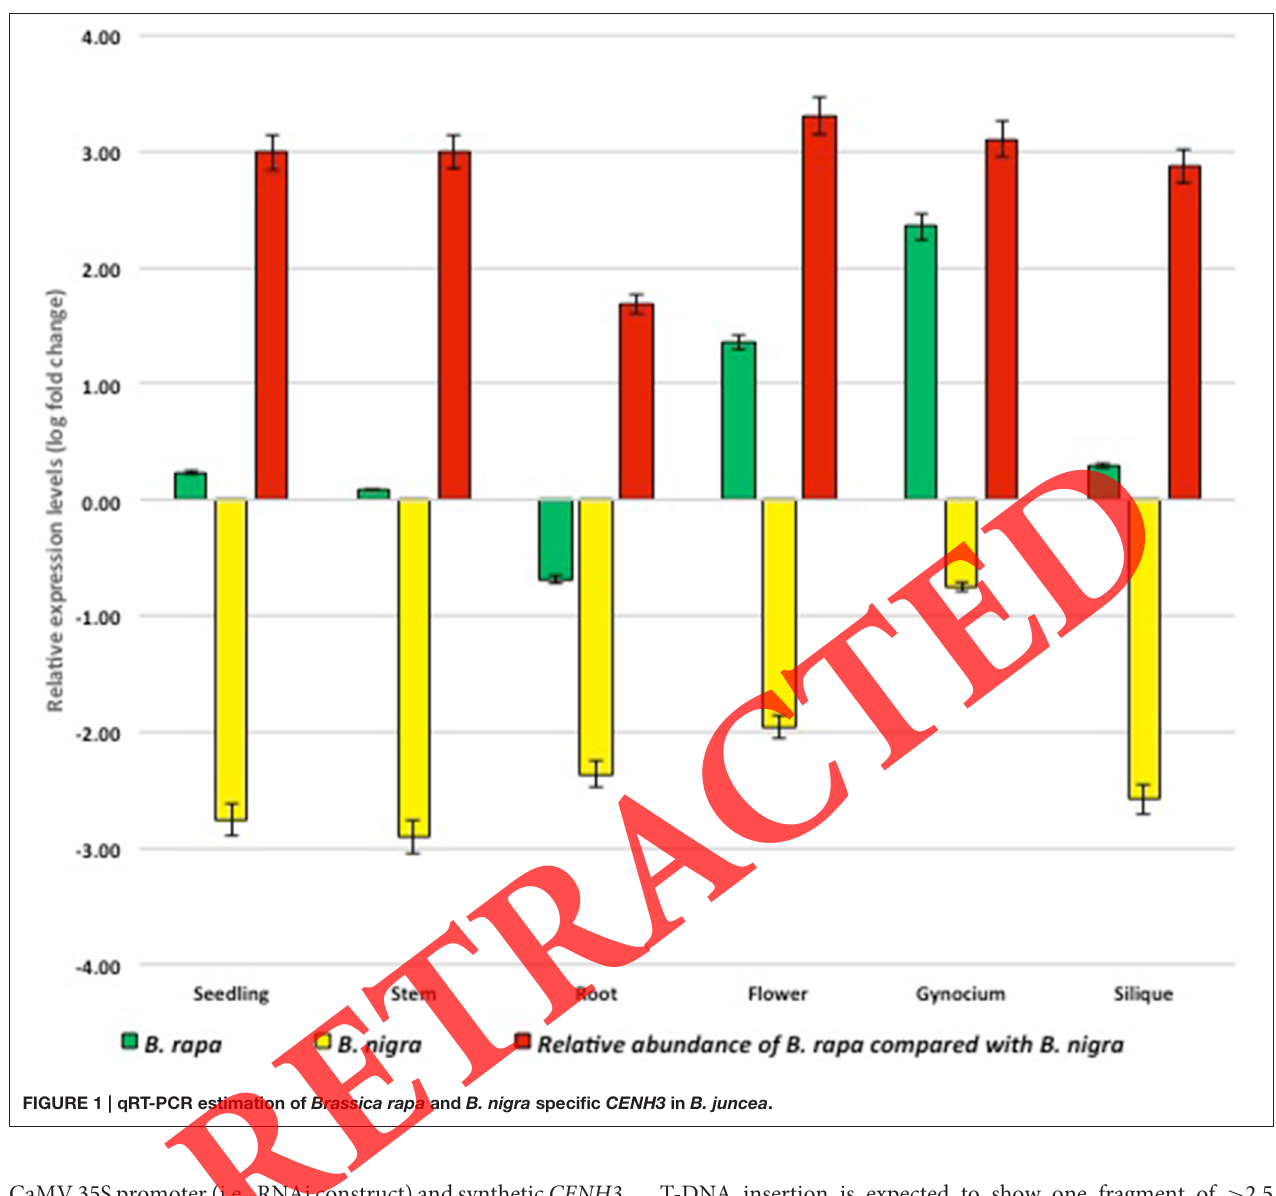
FIGURE 1 | qRT-PCR estimation of Brassica rapa and B. nigra specific CENH3 in B. juncea